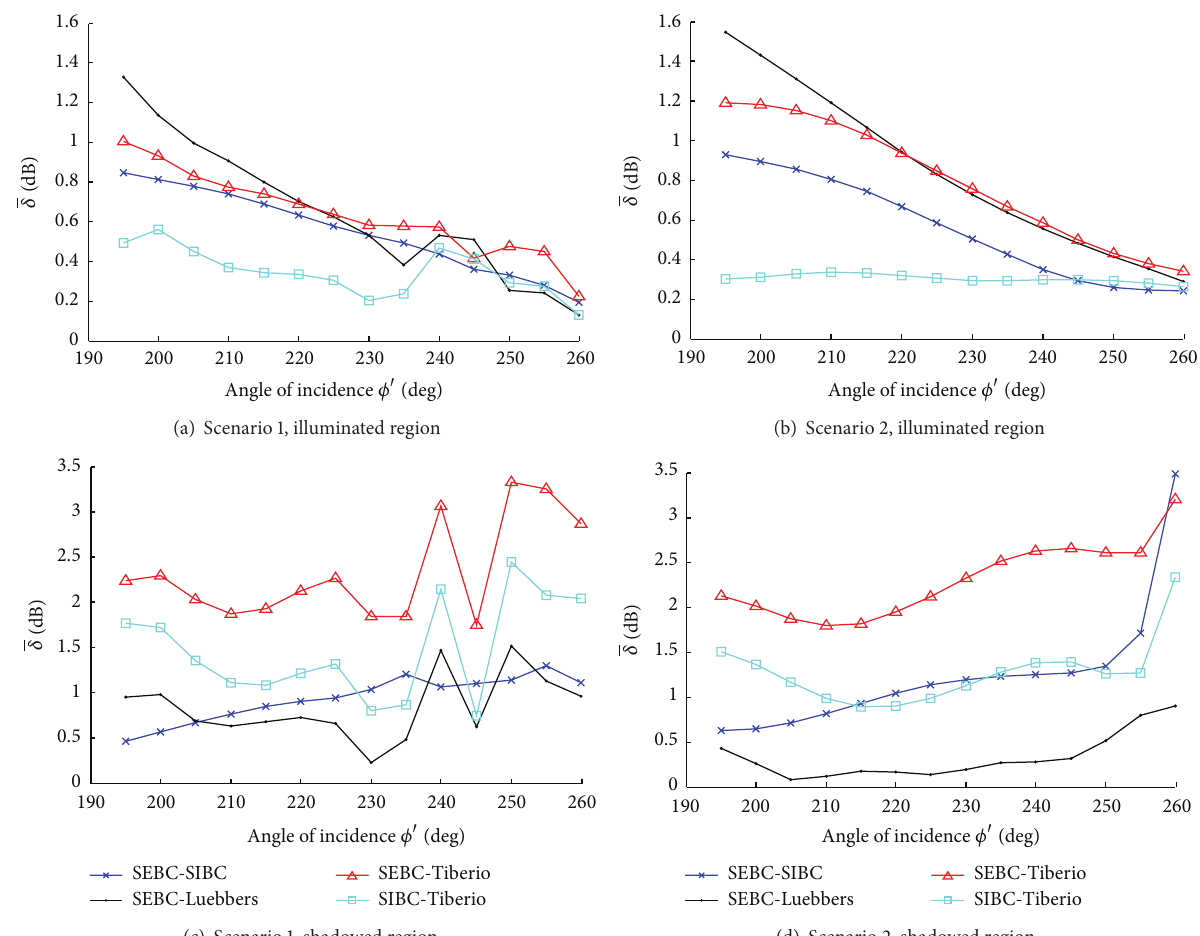
Figure 2: Trend of 𝛿 averaged over the angles of